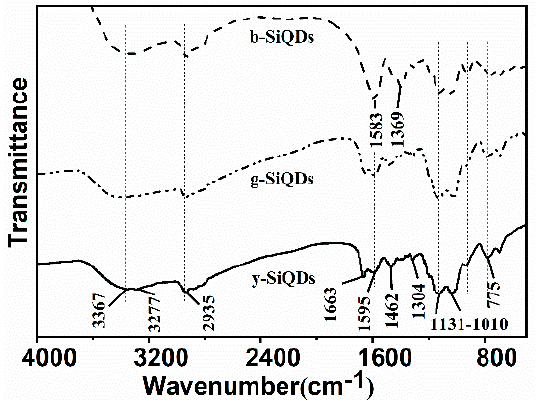
Figure 6. FT-IR spectrum of the three kinds of SiQDs (b-SiQDs, g-SiQDs, and y-SiQDs).